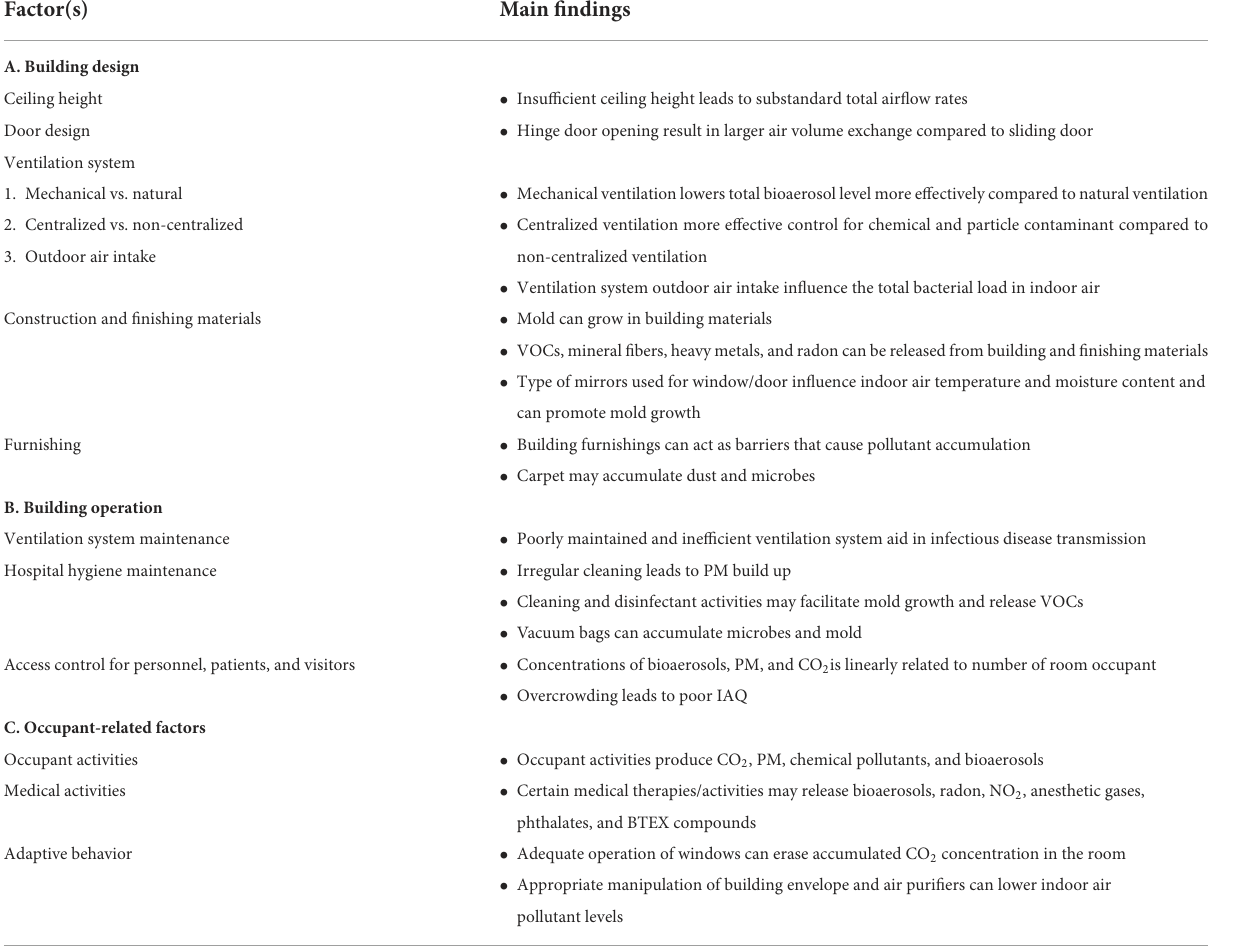
TABLE 1 Summary of previous studies’ main findings on factors related to hospital IAQ. Factor(s) Main